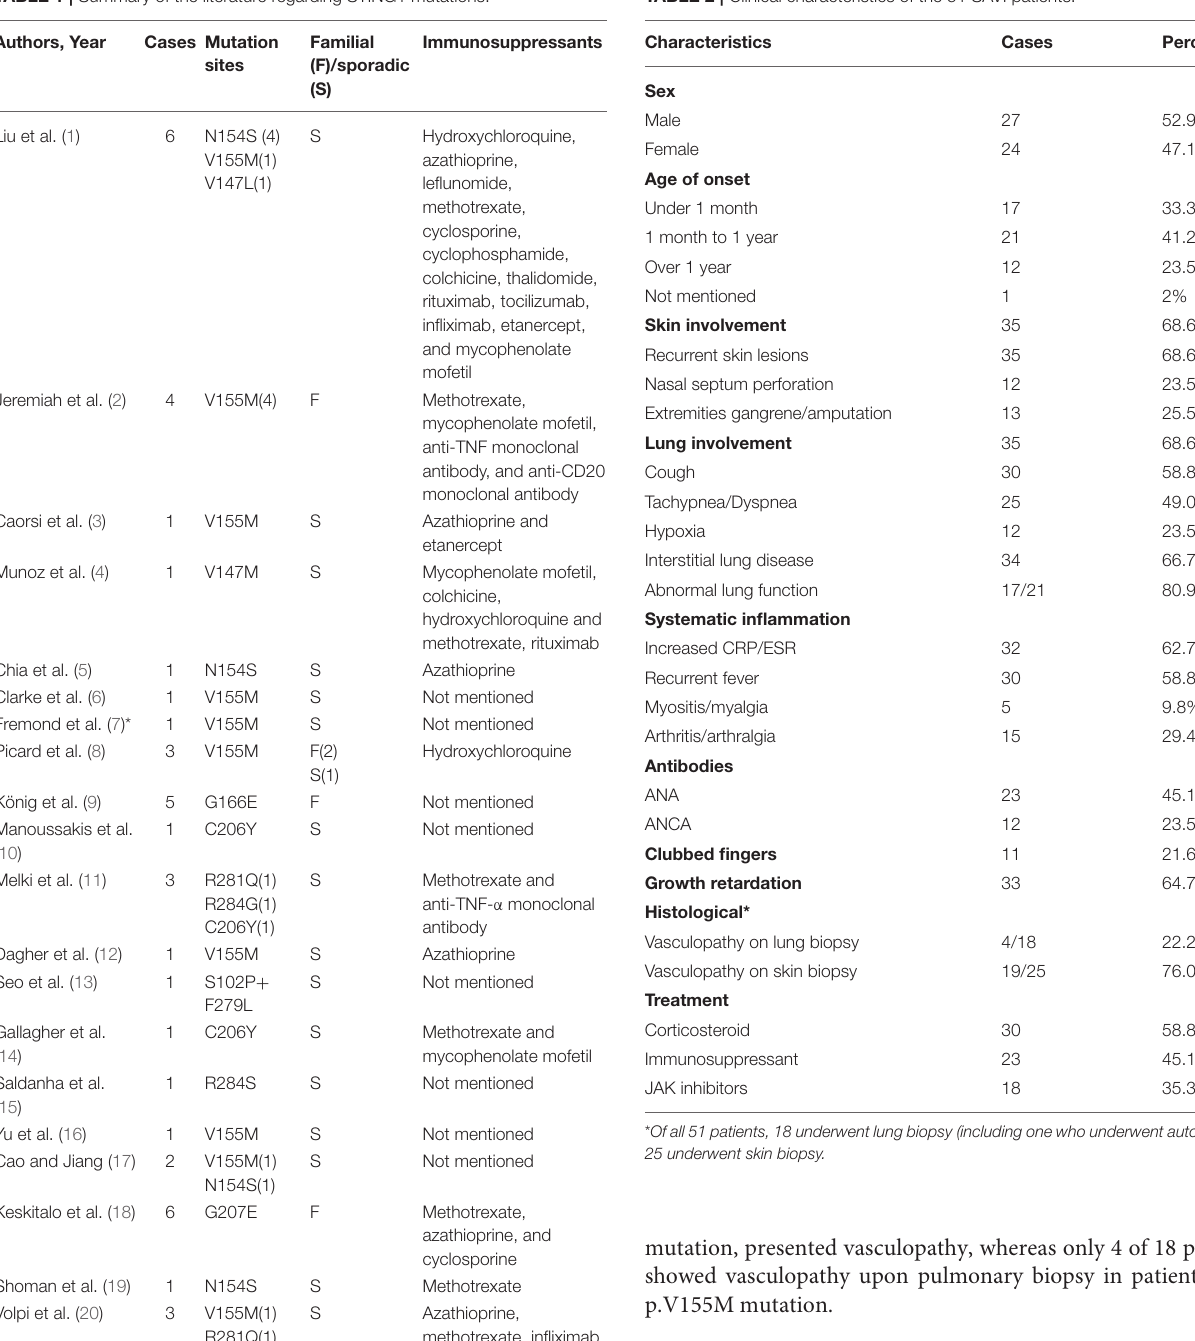
TABLE 1 | Summary of the literature regarding STING1 mutations. TABLE 2 | Clinical characteristics of the 51 SAVI